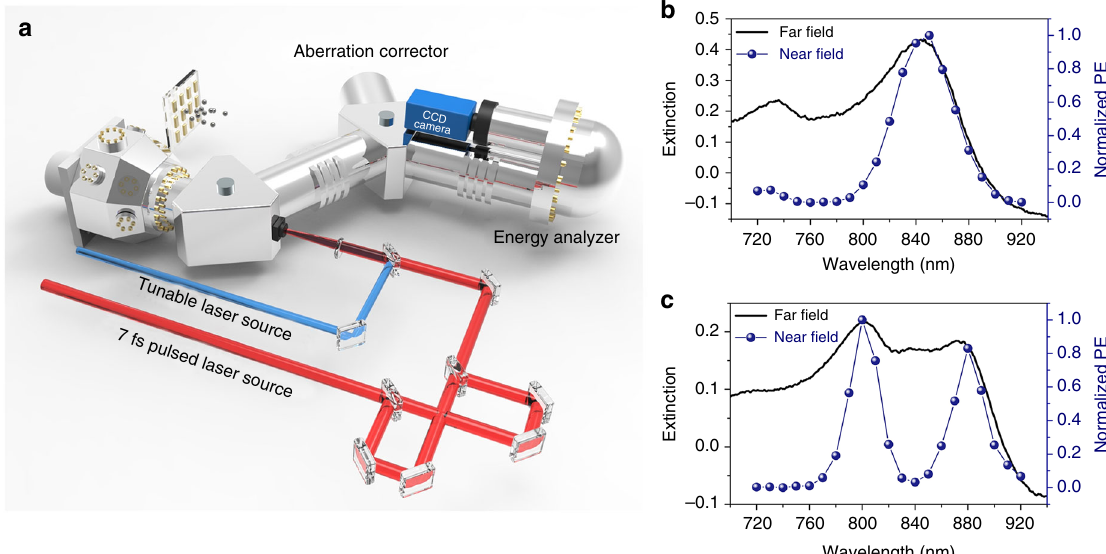
Fig. 4 Near- fi eld and far- fi eld measurements. a Sketch of the photoemission electron microscopy (PEEM) con fi guration with two kinds of laser sources. b , c Far- fi eld spectra (solid lines) and near- fi eld photoemission (PE) intensity curves with different detuning characteristics. In b , the 400nm period and 115 nm nanoblock correspond to the large detuning conditions (221 meV). In c , the 500 nm period and 115 nm nanoblock correspond to the small detuning conditions (25